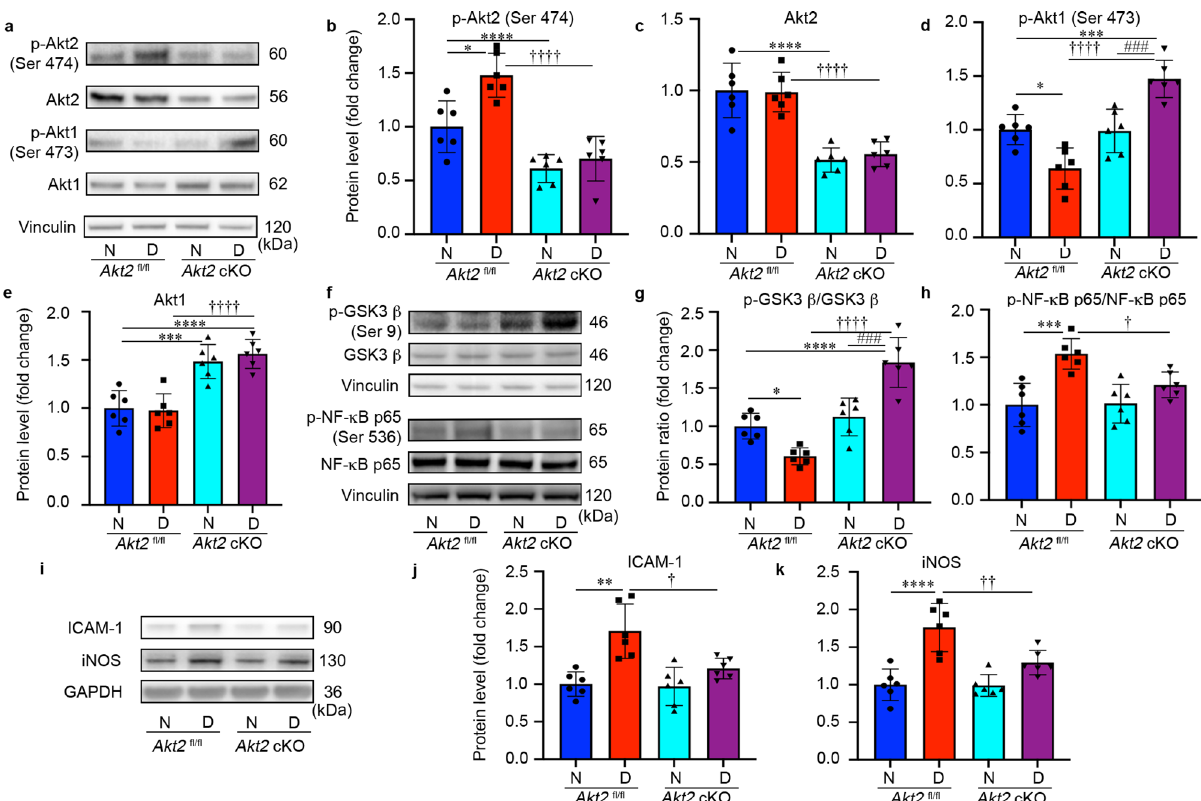
Fig. 8 | Akt2 cKO promotes upregulation of Akt1 and inhibits the diabetes- induced in fl ammatory response through GSK3 β /NF- κ B signaling in the RPE cells(2months ofdiabetes).a Representative immunoblots and quanti fi cation of ( b ) phospho- Akt2 , ( c ) total- Akt2 , ( d ) phospho-Akt1 and ( e ) total Akt1 in RPE lysates obtained from diabetic and nondiabetic Akt2 fl / fl and cKO mice. Diabetes increased the level of phospho- Akt2 but did not affect the levels of total Akt2 in Akt2 fl / fl RPE cellscomparedtothenondiabeticcontrol.RPE-speci fi c Akt2 cKOreducedthelevels of both phospho- and total- Akt2 in the RPE; induction of diabetes did not further affect the levels of either phospho- or total Akt2 in Akt2 cKO RPE. Induction of diabetes in Akt2 fl / fl mice decreased the level of phospho-Akt1 but did not affect the levels of total Akt1 in the RPE cells compared to nondiabetic control. Akt2 cKO increased the levels of phospho-Akt1 in diabetic Akt2 cKO mice, but not in non- diabetic cKO mice compared to diabetic or nondiabetic Akt2 fl / fl mice, respectively. The total Akt1 in the RPE was upregulated in both nondiabetic and diabetic Akt2 cKO mice compared to Akt2 fl / fl mice. f Representative immunoblots. g The ratio of phospho-GSK3 β /total GSK3 β was lower in diabetic Akt2 fl / fl mice, relative to non- diabetic control mice. However, it was increased in diabetic Akt2 cKO mice. h In addition, Akt2 cKO rescued the diabetes-induced increase in the ratio of p-NF- κ B p65/total NF- κ B p65. i Representative immunoblots. Diabetes induction